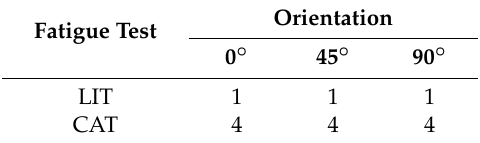
Table 2. Total number of tested specimens for fatigue testing.